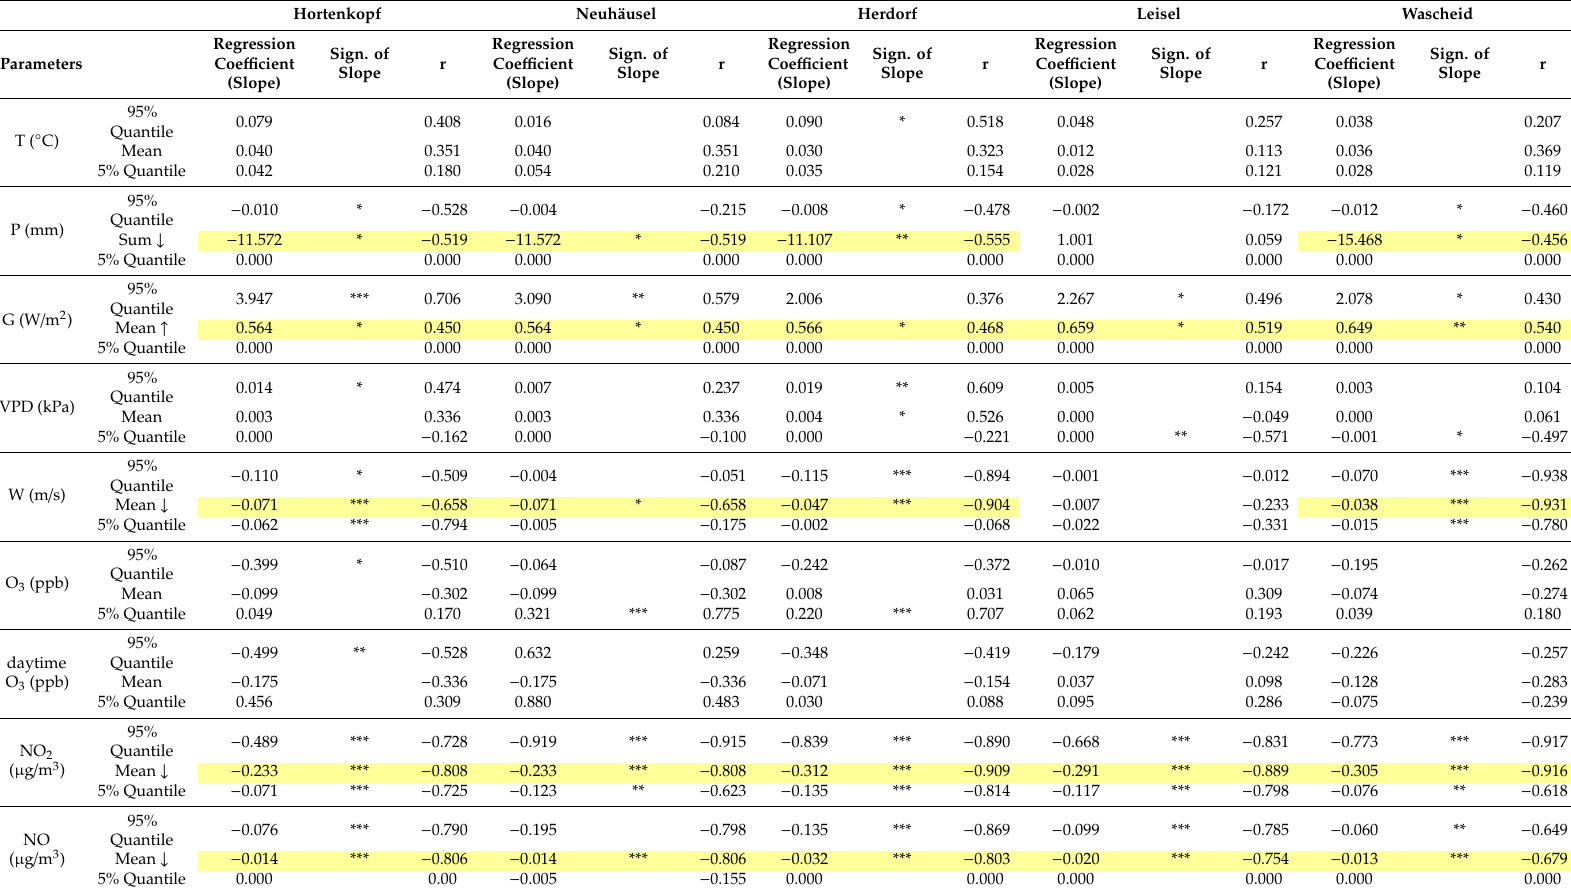
Table 3. Regression coe ffi cients and Pearson correlation coe ffi cients r of yearly means from pollutants and meteorological parameters of all sites during 1998–2019 (n = 22, except n = 21 for O 3 in Neuhäusel and n = 20 for NO 2 and NO in Wascheid), and symbols for significance levels of regression coe ffi cients: * α = 0.05, ** α = 0.01 and *** α = 0.001. The light-yellow accentuation of some lines indicates main temporal trends of most sites to the same direction tagged by an arrow towards the left side of the table. The regressions of 95% quantiles mark the upper 5% peak values and respectively the 5% quantiles the 5% lowest values of the time series. They represent temporal trends of the extreme values. The quantiles were generated from 24 h (daily)